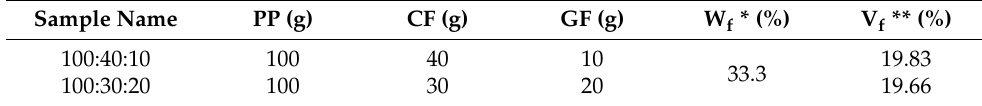
Table 2. PP/CF/GF formulation for the composite